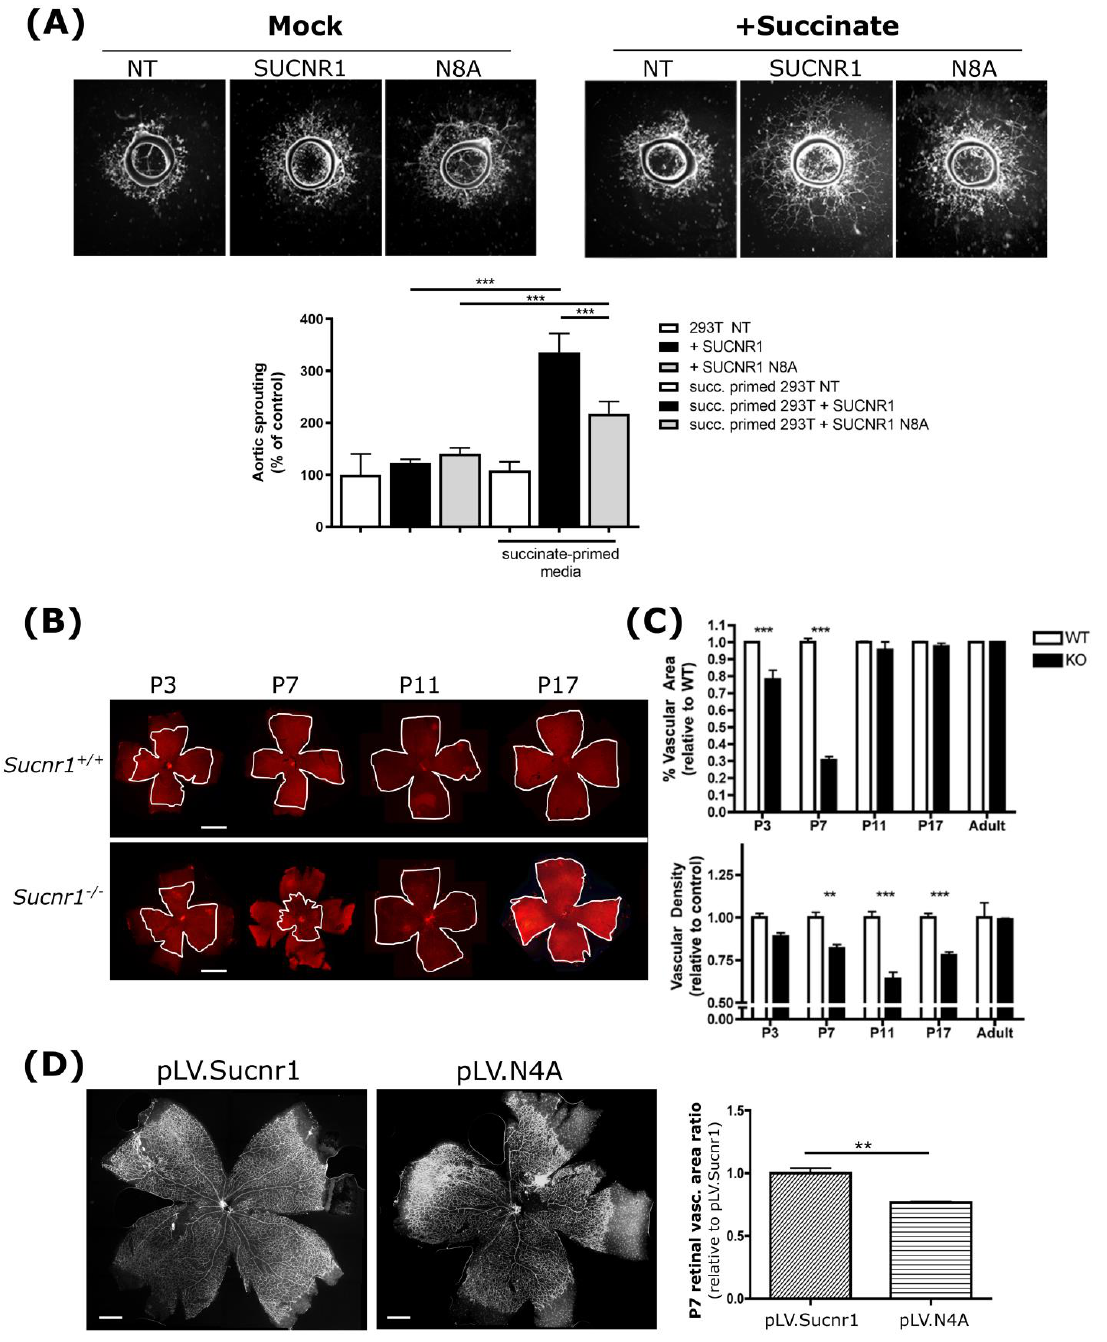
Figure 6. SUCNR1 − N8A has a reduced retinal revascularization potential. ( A ) Female rat aortic ex- plants were incubated in conditioned media from HEK 293T cells transfected with the correspond-